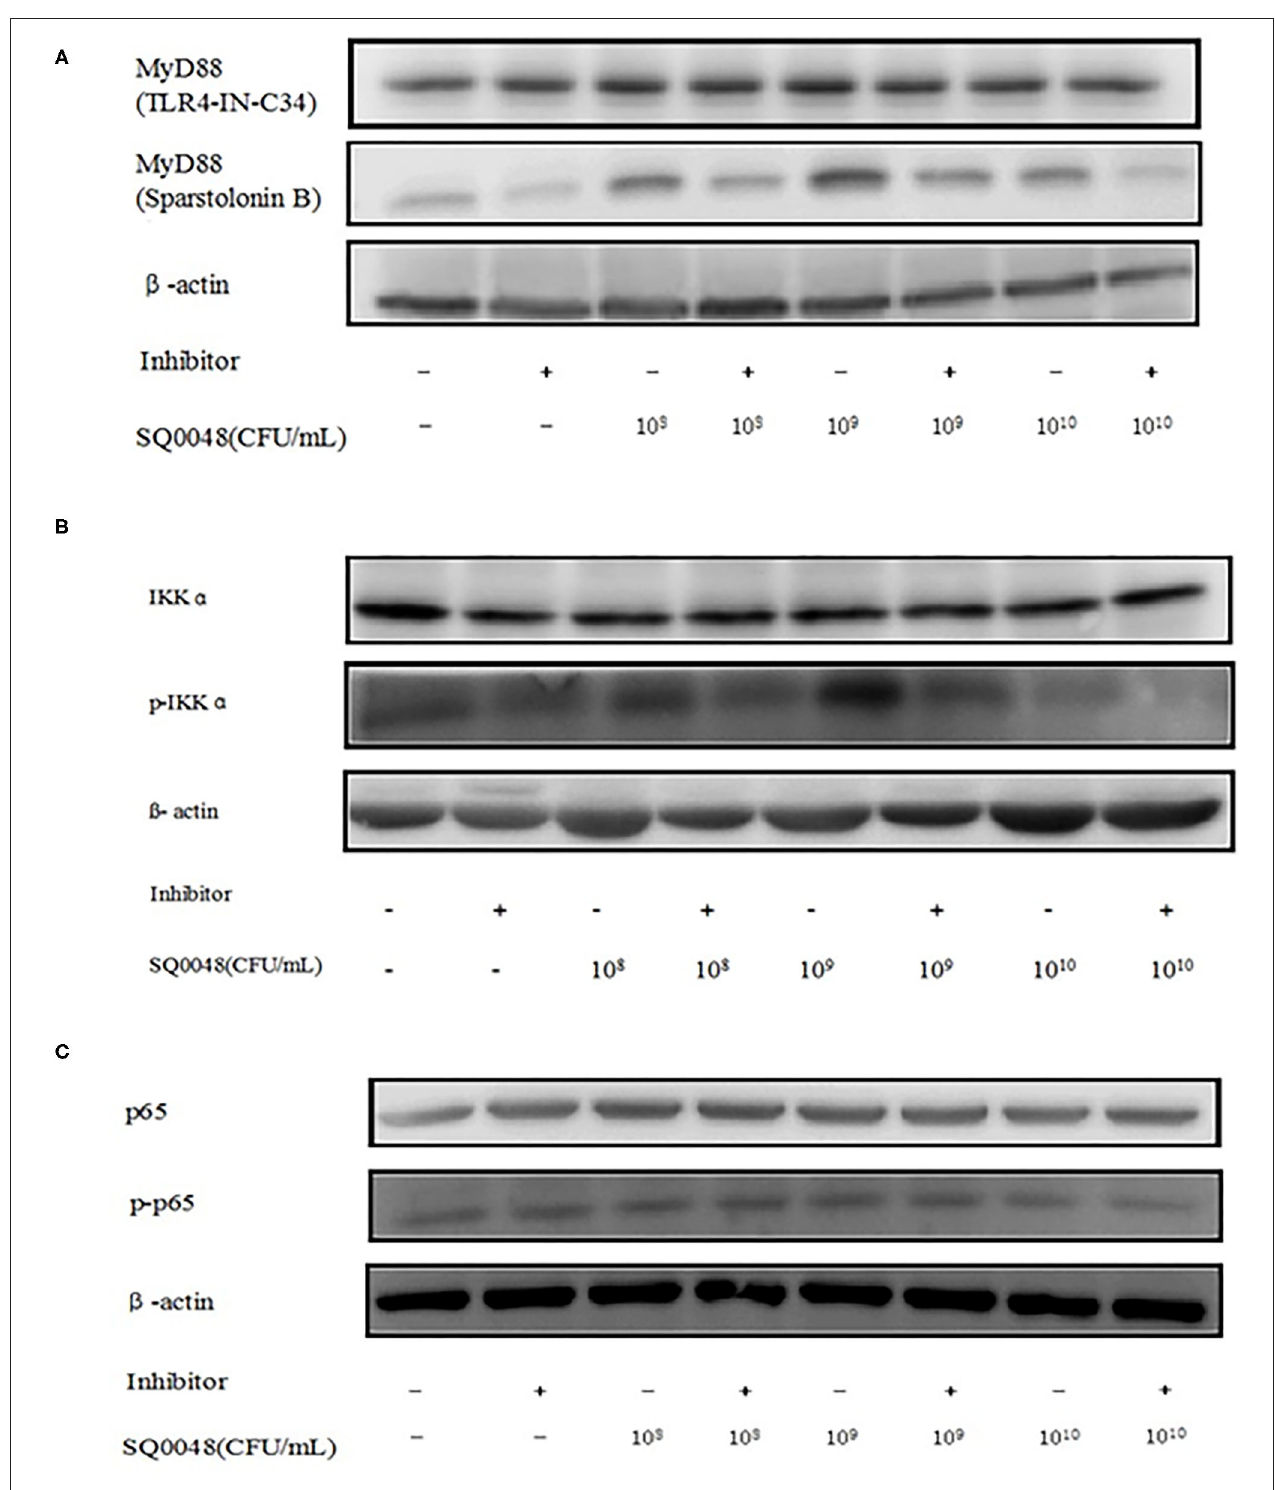
FIGURE 3 | Protein expression levels of MyD88, IKK, and NF- κ B after treatment with TLR4-IN-C34 and Sparstolonin (A) , B,PD98,059 (B) , and Mesalamine (C) in BVECs.